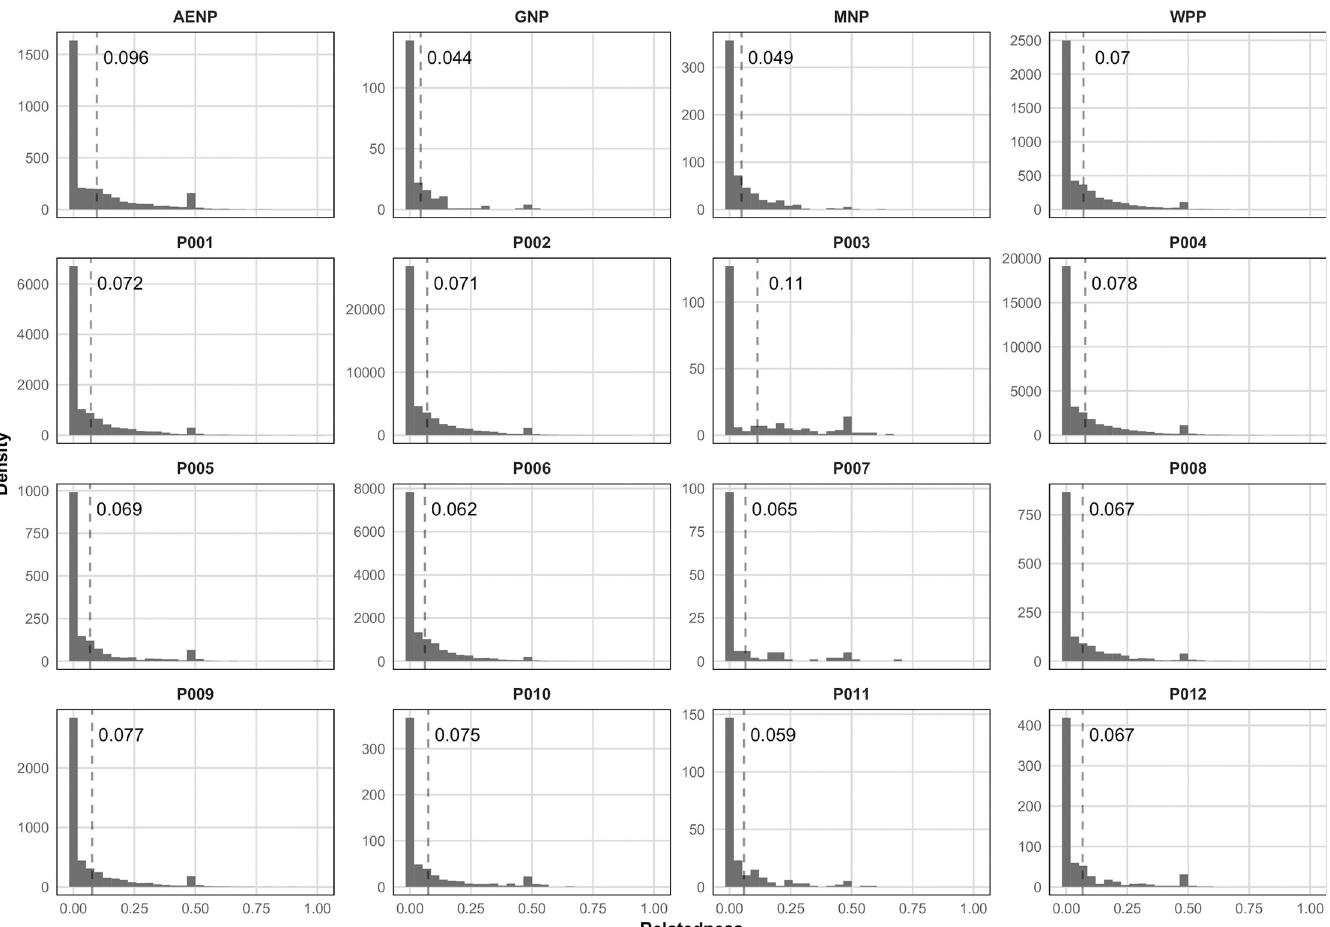
Fig 2. Pairwise relatedness distributions per locality. Density histograms were constructed with ggplot2 v3.3.0 [40] in R, with 30 bins for all histograms. The dashed line on each plot indicates the mean relatedness, with the text inset showing the value of the mean. Note that the y-axes scales are independent between plots to aid in visualization of the distribution for each locality, due to the large range of sample sizes in this data